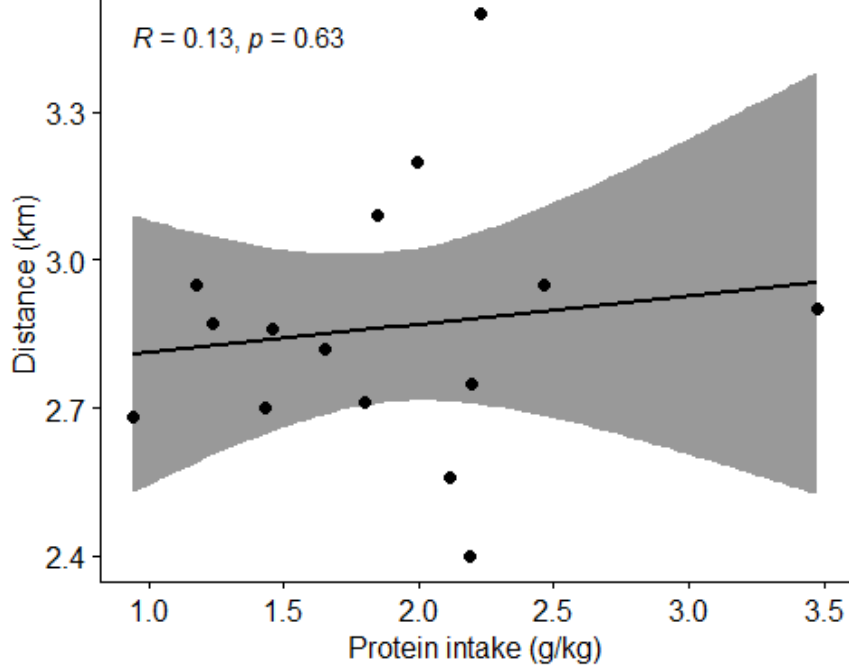
Figure 16. Correlation between protein intake and distance covered by subjects in the Cooper test. Grey shaded area indicates 95% CI. Dots represent individual participants ( n = 15).